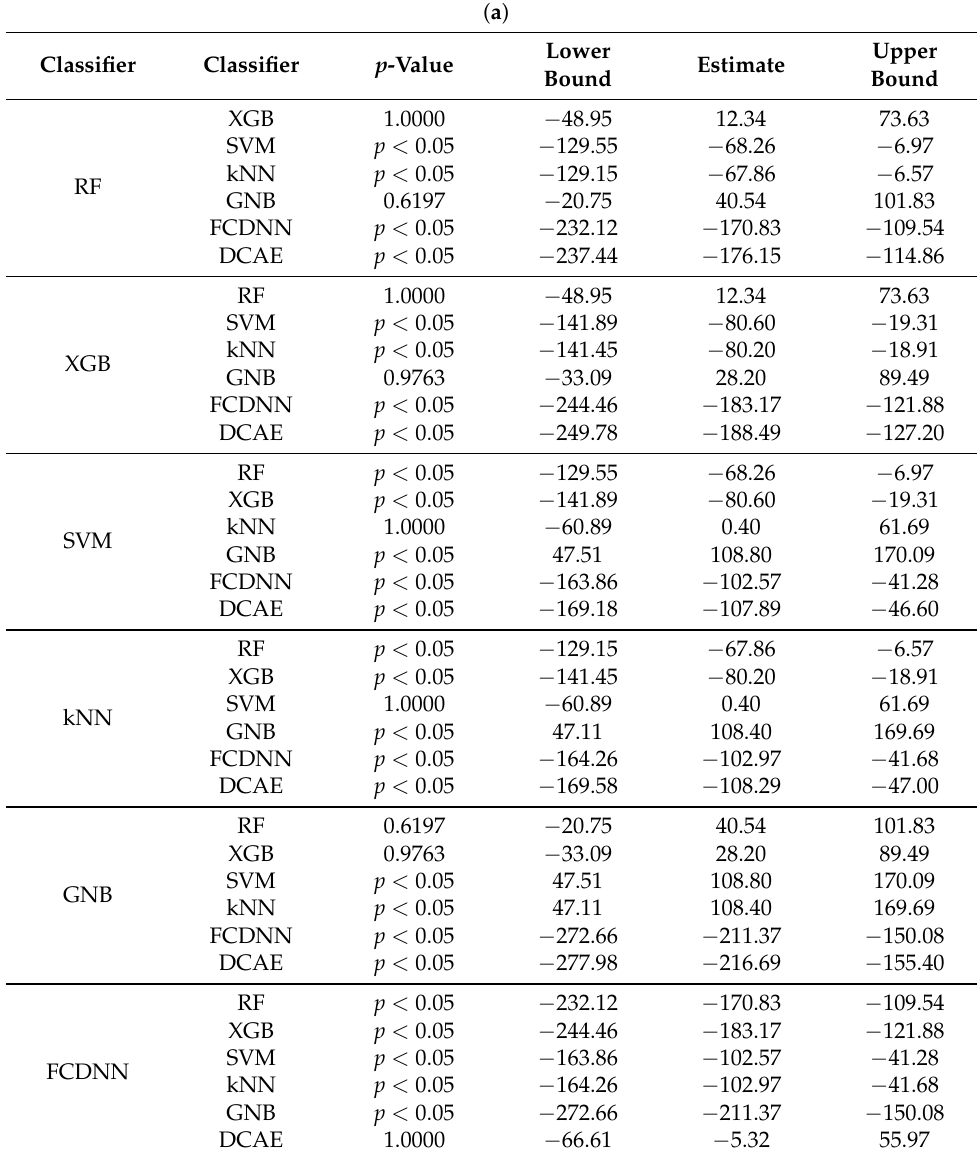
Table 5. Multiple comparison using Kruskal-Wallis test to establish H 0 3 of F1-scores for all classifiers with ( a ) DS1 and ( b )